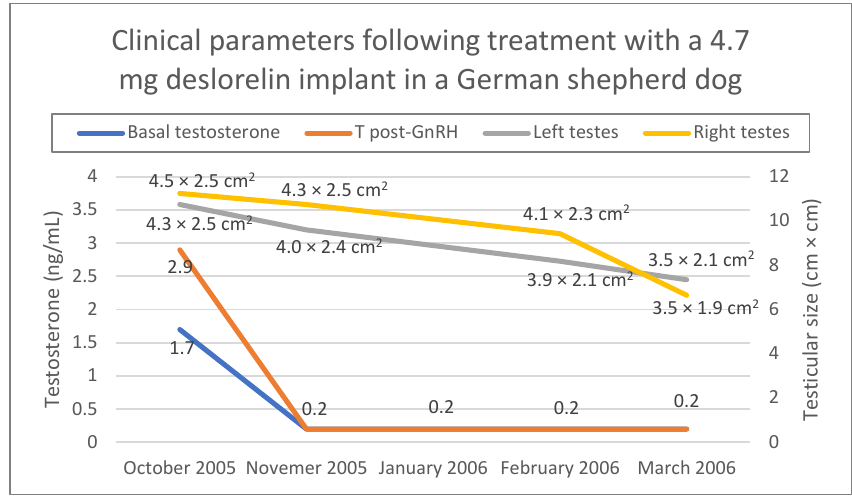
Figure 4. Clinical parameters (testicular size, serum testosterone concentration before and one hour after a stimulation test with 50 μg gonadorelin SC) of a German shepherd dog treated with a 4.7 mg deslorelin implant. Testosterone concentration was measured with chemiluminescence immunoassay. Testicular size was measured during ultrasonographic examination.